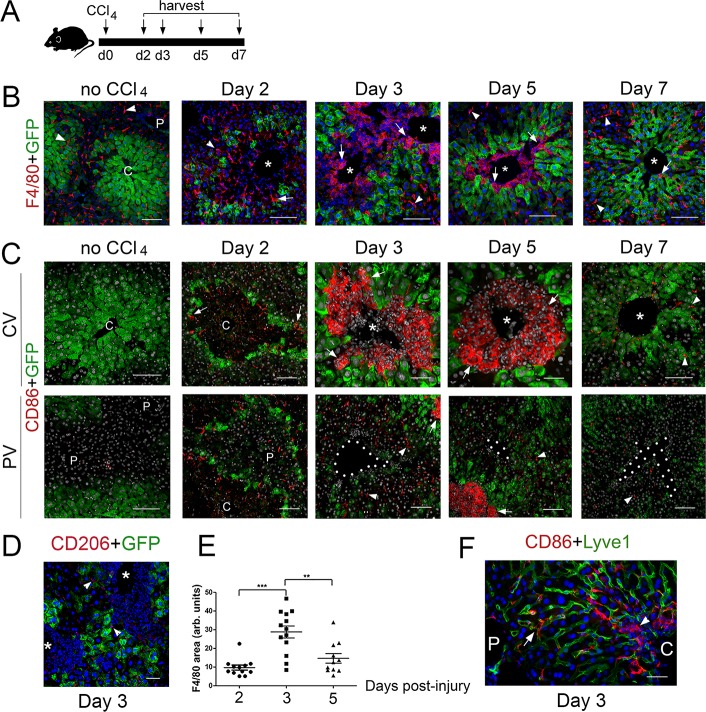
M1 macrophages infiltrate the perivenous space in CCl4-acutely injured livers.(A) Experimental strategy for Cldn2-EGFP mice injected with CCl4. (B) (No CCl4) Results of double-immunofluorescence analysis show expression of the pan-macrophage marker F4/80+ in Kupffer cells (arrowheads) in a control adult liver (no CCl4 injection). (Day 2–5) In the CCl4-injected Cldn2-EGFP liver, macrophages (arrows) start to infiltrate the necrotic perivenous area at day two and form a physical barrier between the central vein endothelium and the expanding GFP+ Zone 2 at days 3 and 5. Resolution of macrophage perivenous infiltrates and restoration of claudin-2/GFP expression occur 7 days post-CCl4 injection (arrows are Kupffer cells). (C) (No CCl4) M1 macrophages (CD86+) are not detected in perivenous or periportal regions in Cldn2-EGFP control mice (C is central vein, P is portal vein). (Day 2–5, top) Immunofluorescence images of CCl4-injected Cldn2-EGFP livers showing increasingly abundant infiltrates of CD86+ macrophages (arrows) 2 days post-CCl4 and persistence of these cells around the central veins at days 3 and 5. CD86+ macrophages are no longer present in perivenous areas at day 7 (CV, central vein region). (Day 2–5, bottom) CD86+ macrophages are very scarce in periportal areas in CCl4-injected livers (PV, portal vein region). (The exposure in the green channel was decreased for better visualization of the red [CD86] signal. (D) Macrophages infiltrating the perivenous region do not express the M2 macrophage marker CD206 3 days post-CCl4 injection (arrowheads indicate low expression of this marker in LSECs). (E) Quantification of F4/80+ immunofluorescence distribution 2-, 3- and 5 days post-CCl4. p values were determined by one-way ANOVA with Bonferroni’s multiple comparisons test. **p<0.01, ***p<0.001. 3–4 representative fields from three individual livers dissected at the indicated time points were used for quantification. Asterisks and C, central veins. P, portal veins. CV, central vein area. PV, portal vein area. (F) A few CD86+ macrophages are seen within the Lyve1+ hepatic sinusoids in periportal areas of the CCl4 injected liver. CD86+ macrophages are overabundant in perivenous areas (right, ‘C’, arrowhead) in comparison to periportal areas (‘P’). Each image represents 3–4 individual livers. Scale bars: 100 μm (B), (C) [no CCl4, Days 2,7]) Scale bars: 50 μm (C) [Days 3,5], (D,F).Figure 5—source data 1.Quantification of F4/80+ immunofluorescence distribution post-CCl4 injection.